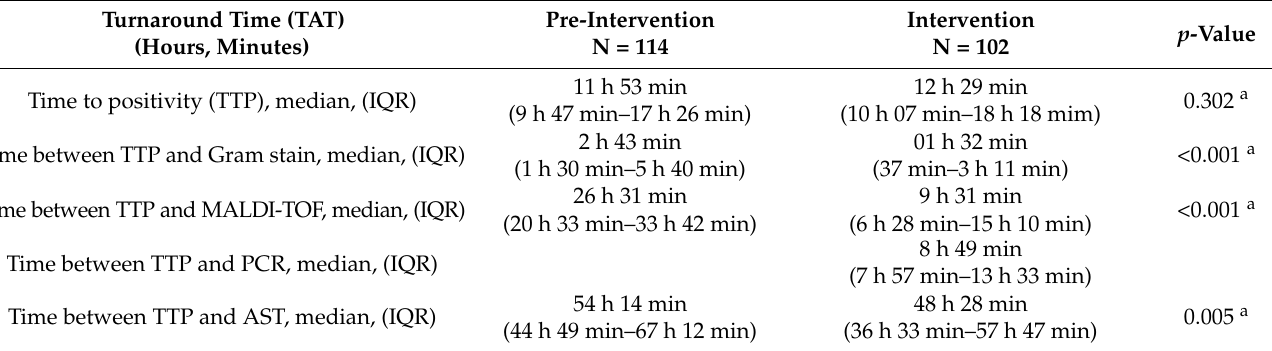
Table 5. Turnaround time (TAT) comparison between pre-intervention and intervention